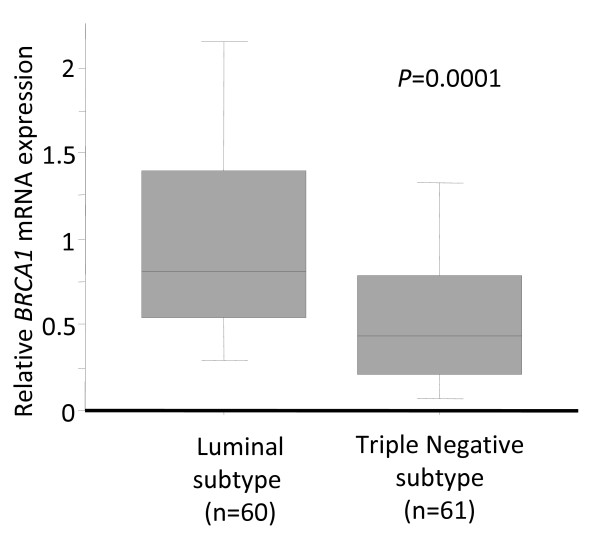
BRCA1mRNAexpression in triple-negative and luminal subtypes in Japanese breast cancer patients.